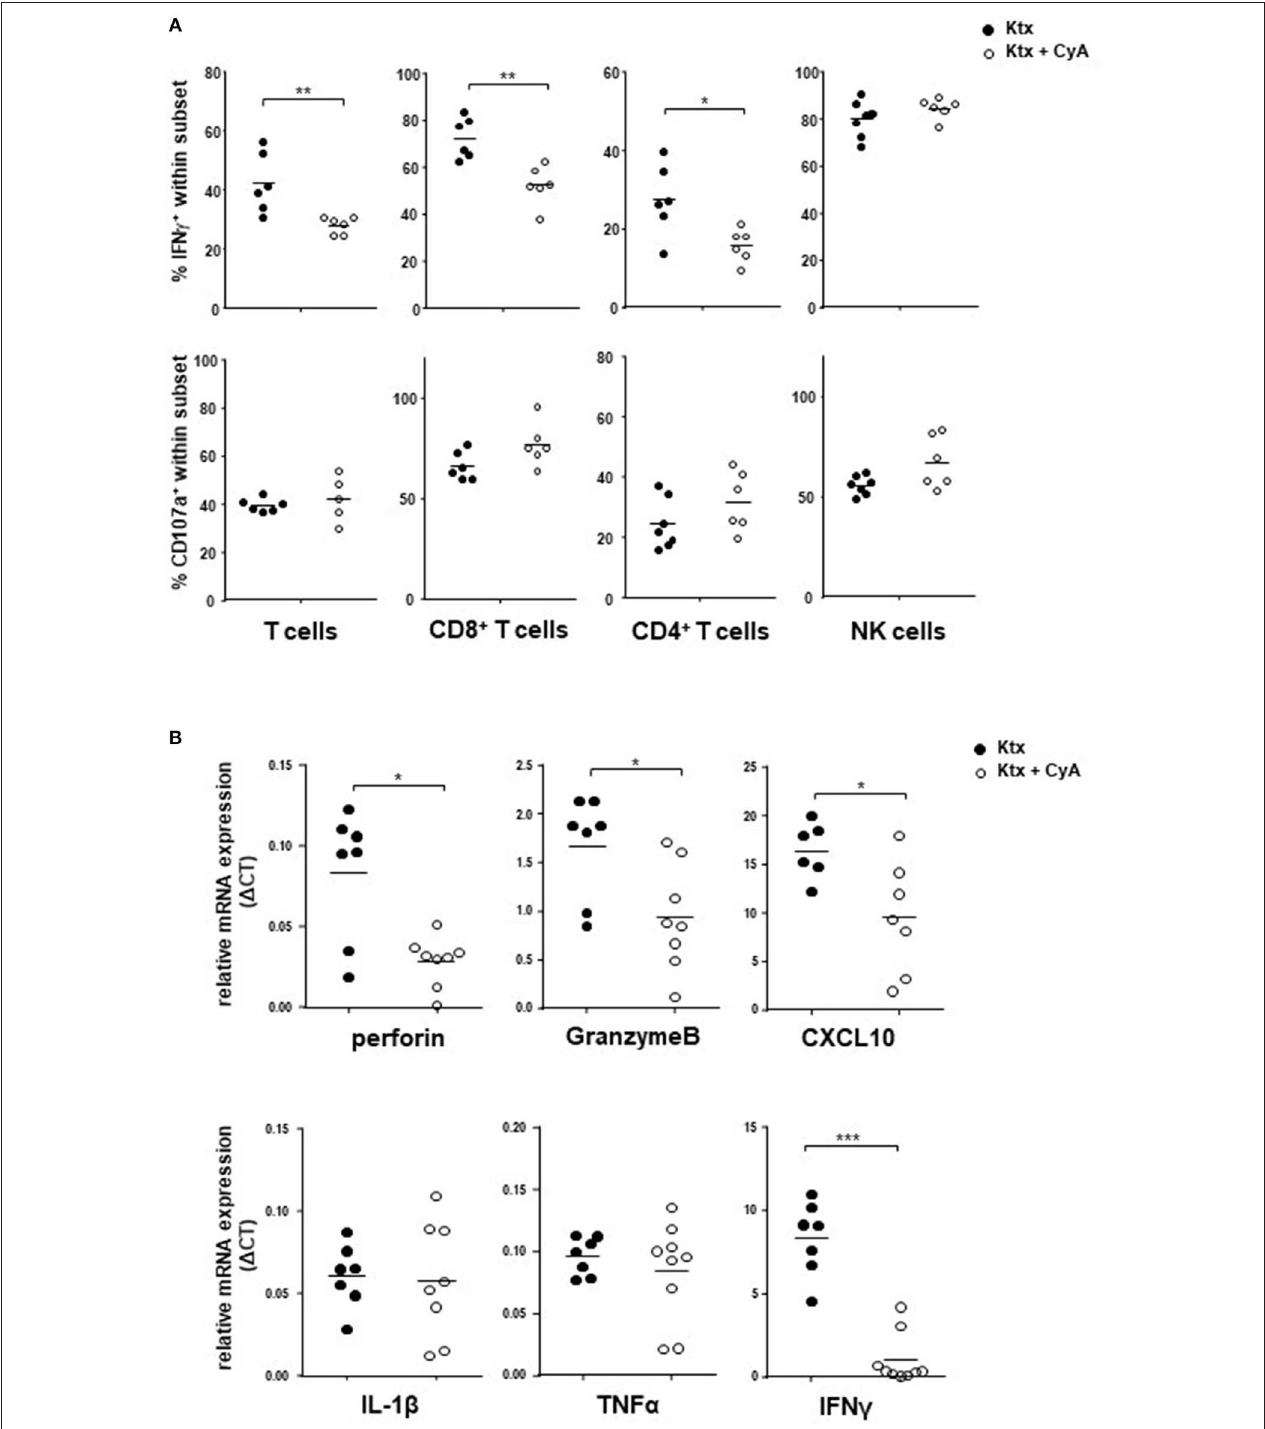
FIGURE 3 | IFN γ production of NK cells is unaffected in CyA-treated recipients. (A) Splenocytes derived from CyA animals or recipients left untreated were polyclonally stimulated with PMA and ionomycin. Whereas both CD3 + CD4 + and CD3 + CD8 + T cells derived from CyA animals illustrate a clear reduction in IFN γ , CD3 − NKp46 + NK cells retain their capacity to produce IFN γ . No impact was observed for the degranulation capacity. (B) Assessment of the intragraft mRNA profile revealed a significant reduction in inflammatory mediators including perforin, granzyme B, CXCL10, and IFN γ in CyA-treated recipients. Data are presented as mean of n = 7–8 animals/group. Cells were pre-gated on live CD45 + events. Statistically significant differences between naïve and CyA-treated animals were tested with the Mann-Whitney U -test; * p < 0.05, ** p < 0.01, *** p < 0.001.